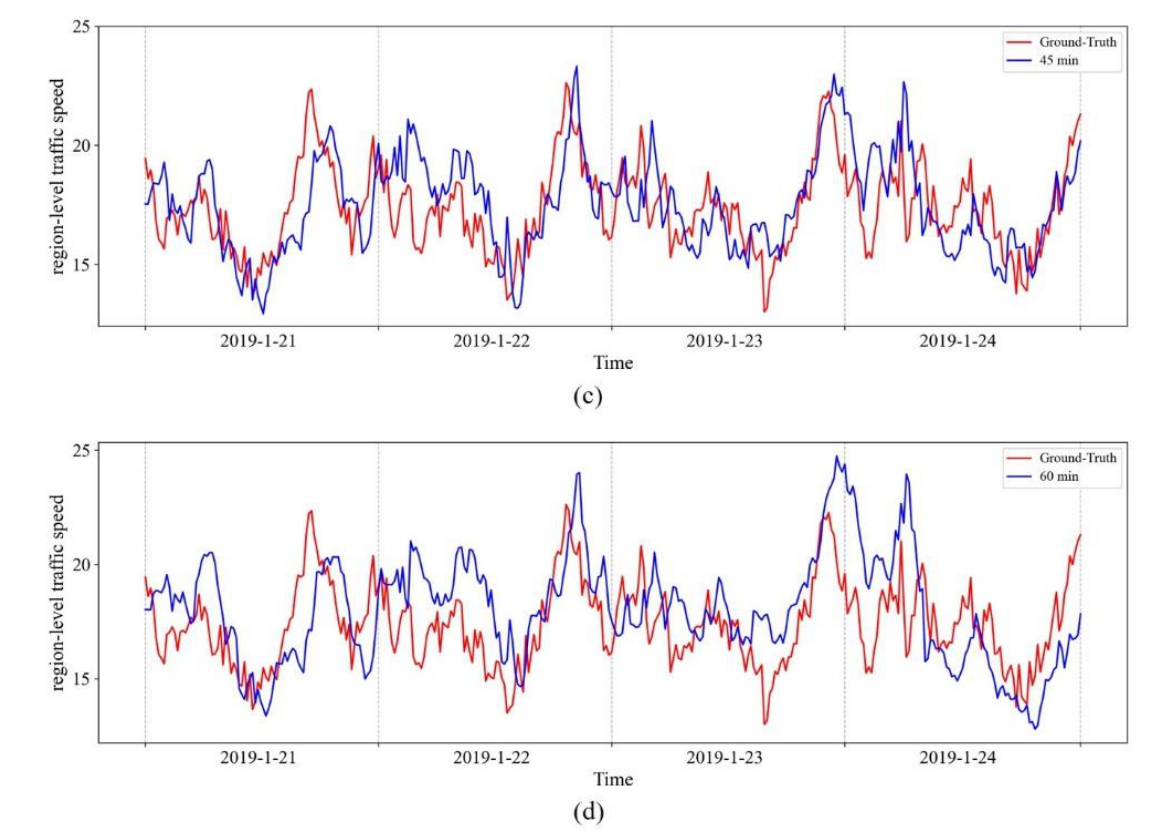
Figure 7. Comparison of Region 60 ground truth and prediction results for 4 prediction horizons: ( a ) 15-min; ( b ) 30-min; ( c ) 45-min; ( d ) 60-min.